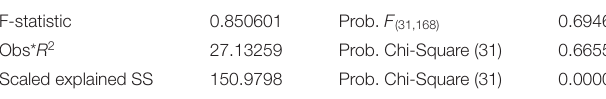
TABLE 6 | White tests. TABLE 7 | Multi-collinearity.